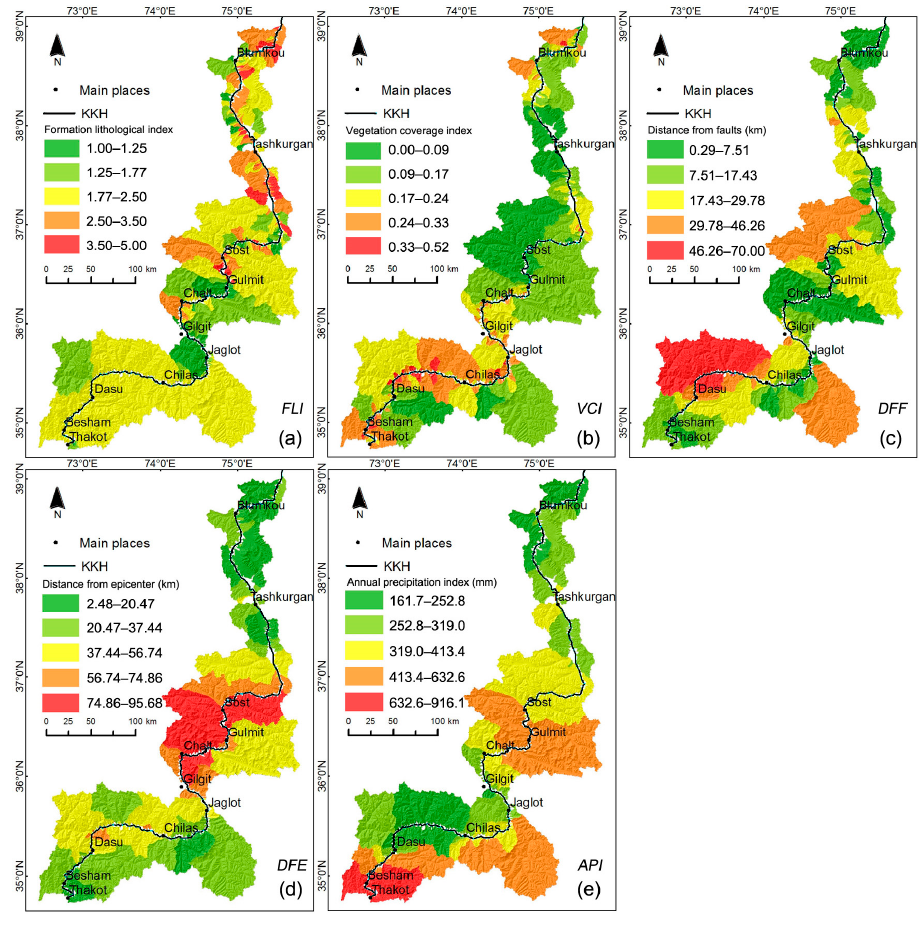
Figure 4. Distribution of parameters of FLI ( a ), VCI ( b ), DFF ( c ), DFE ( d ) and API ( e